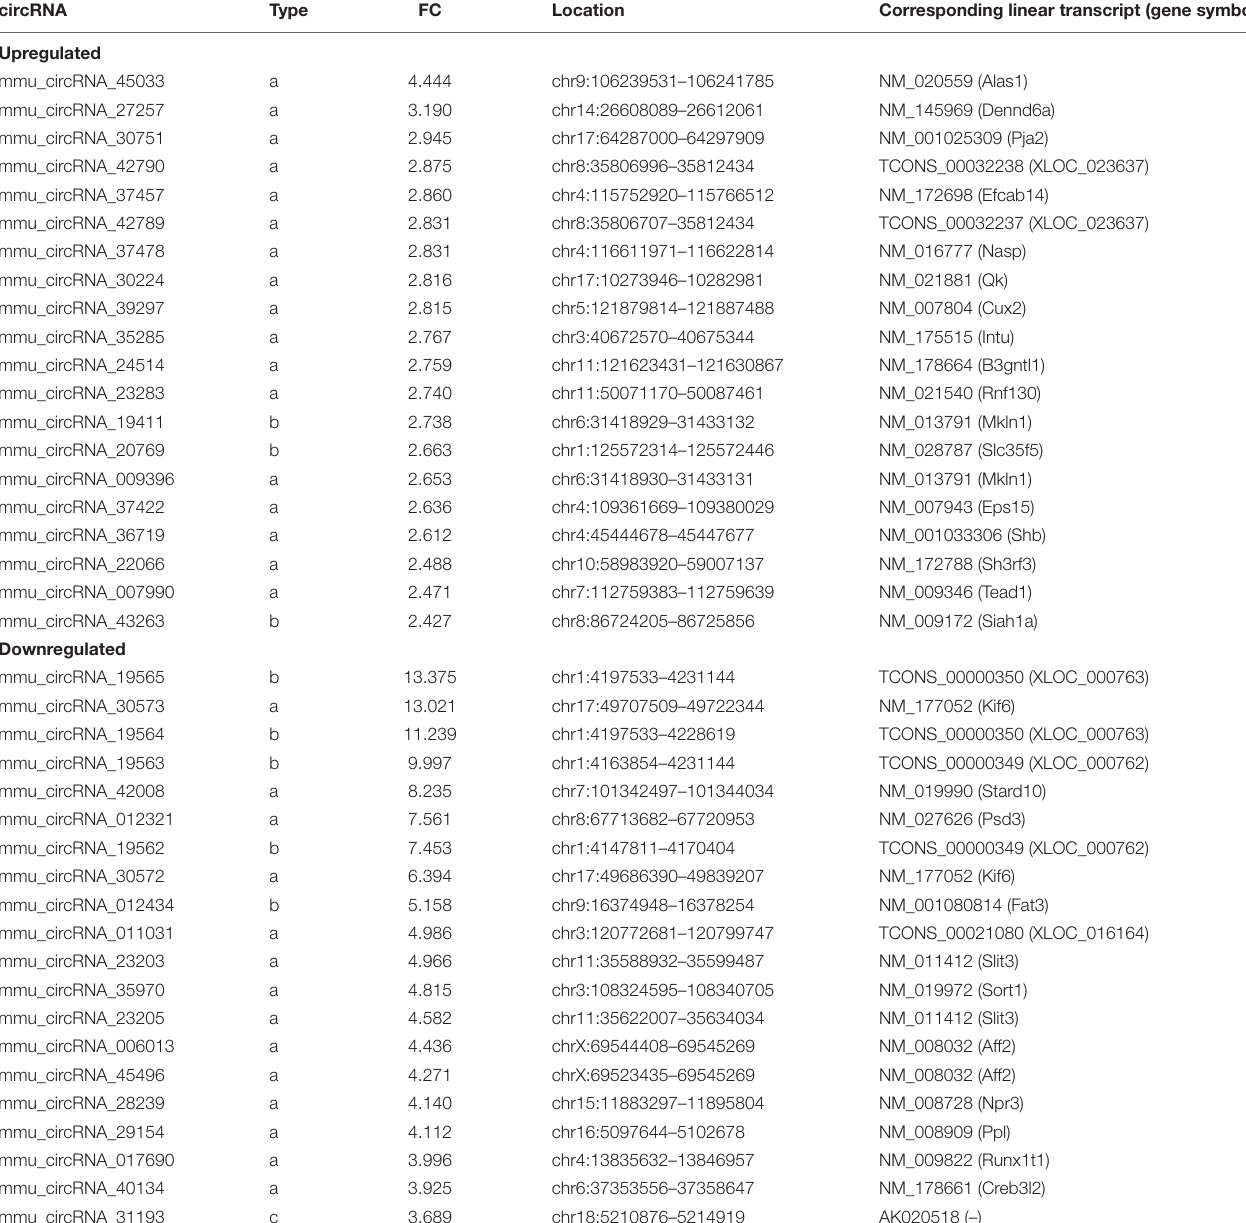
TABLE 4 | Top 40 significantly dysregulated circRNAs in 4W-post-TAC mouse heart. circRNA Type FC Location Corresponding linear transcript (gene